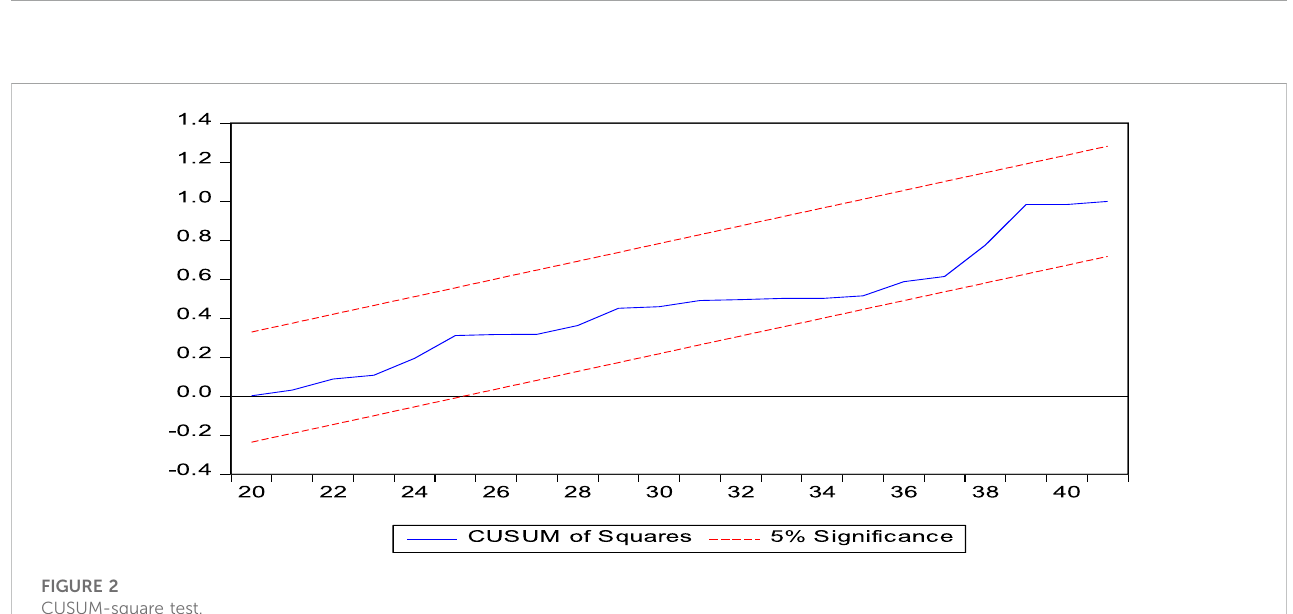
FIGURE 2 CUSUM-square